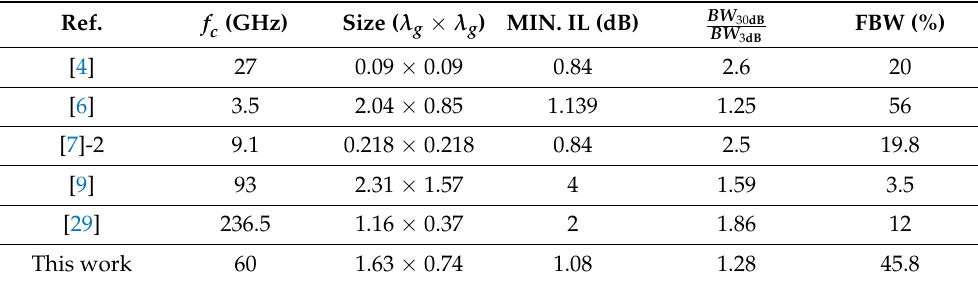
Table 3. Performance comparisons of BPFs operating above millimeter-wave. (All the data are based on the simulation results).